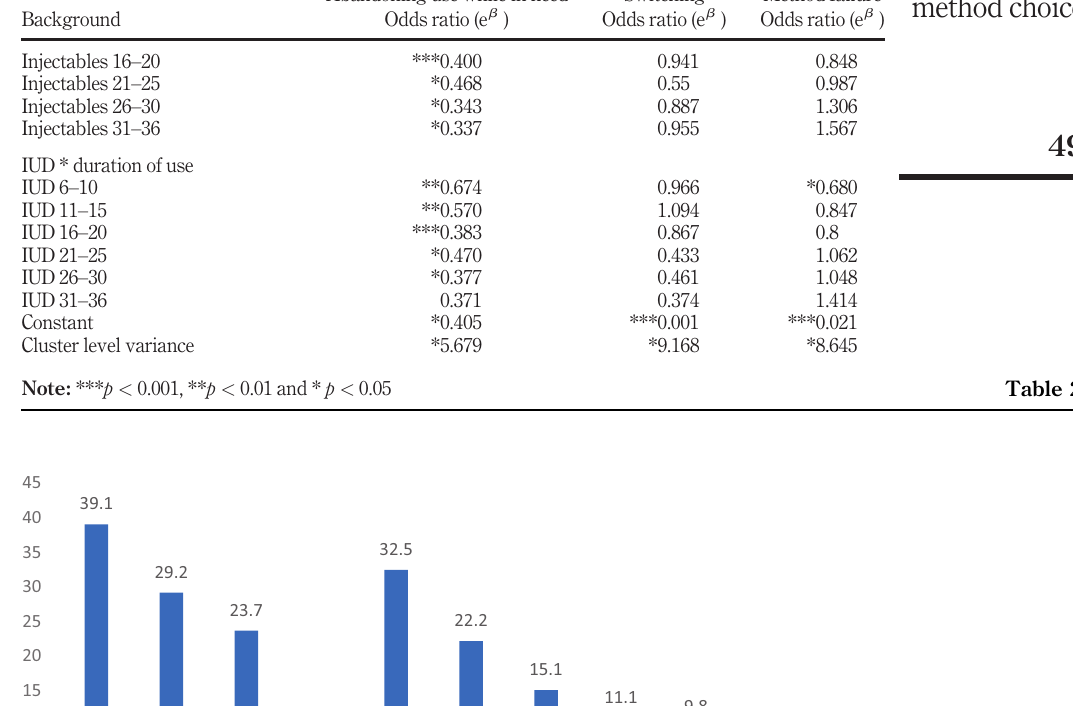
Figure 2. Per cent distribution of characteristics of women